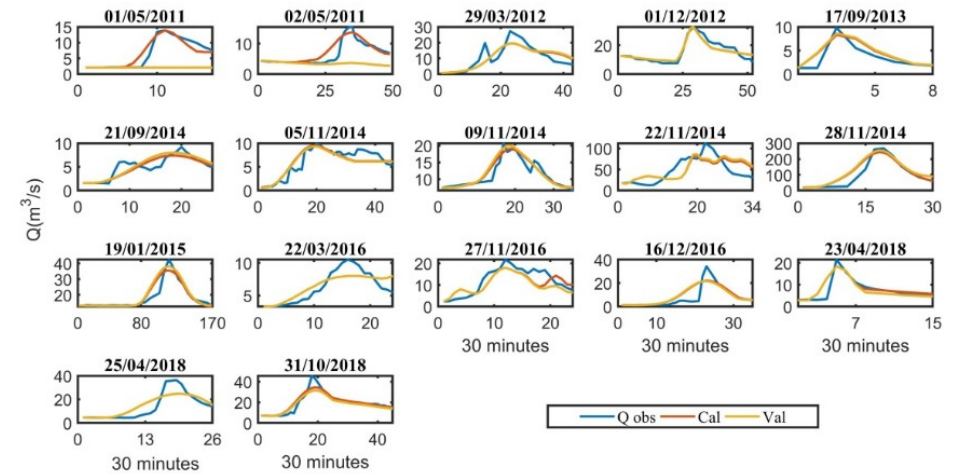
Figure 4. Floods simulated with GPM IMERG-E precipitation.